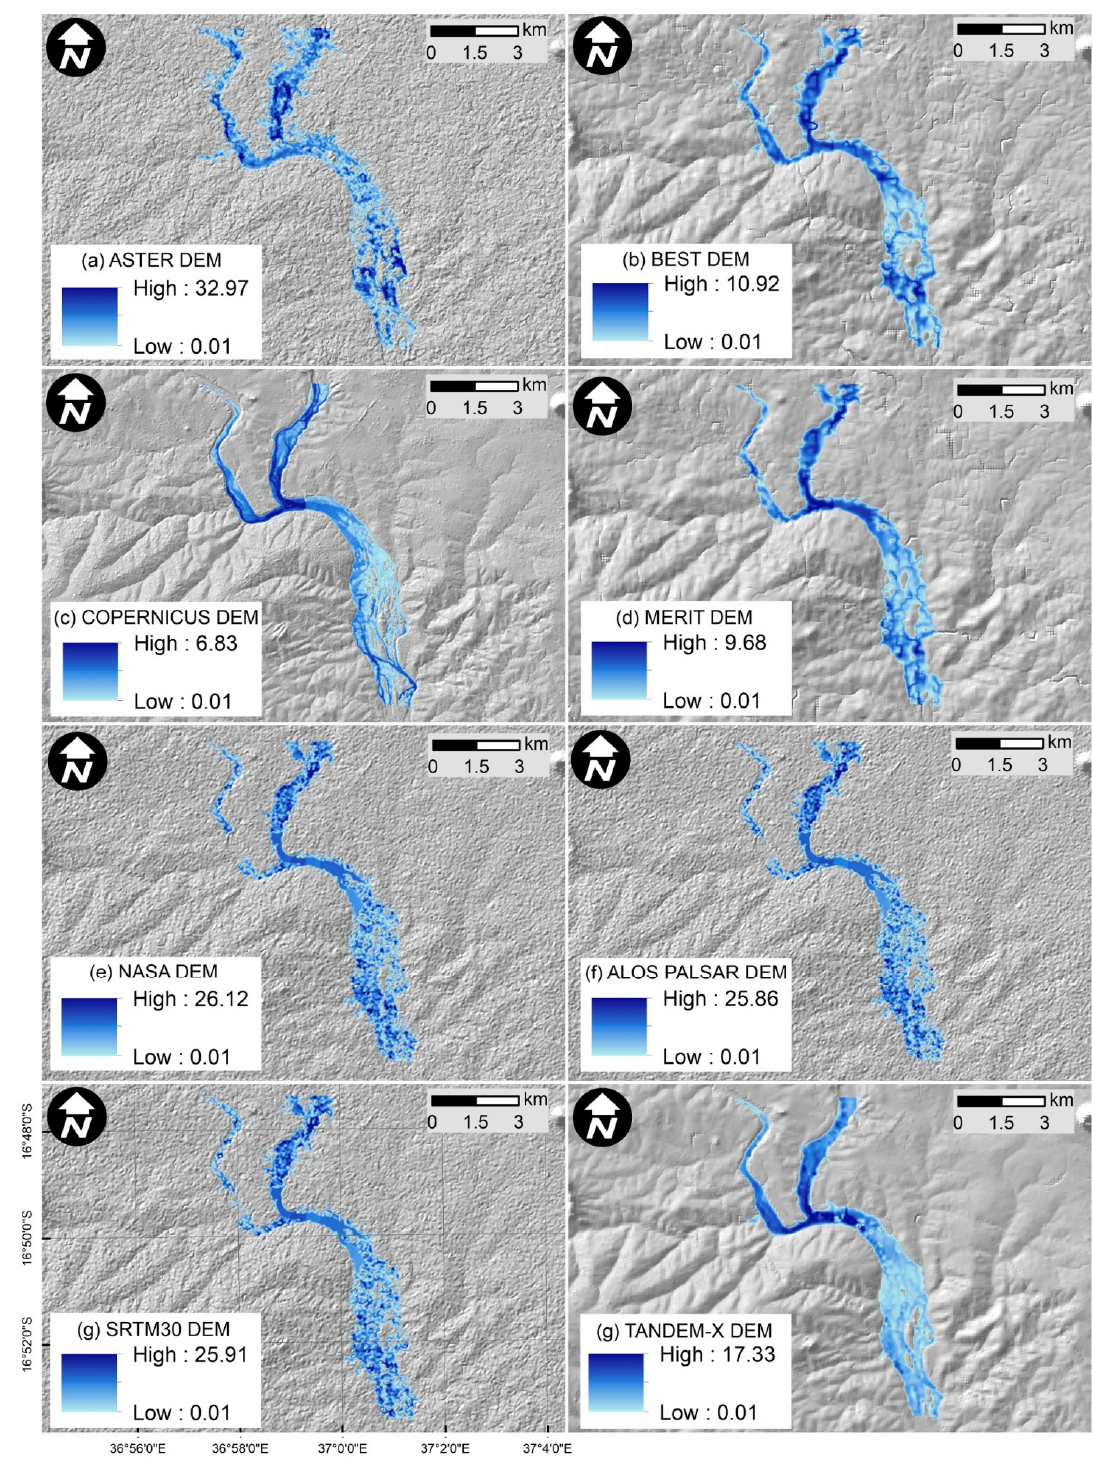
Figure 4. Flow depth results for the 10-years return period peak flow and each one of the free global DEMs used. The effect of noise errors on both the terrain surface and flow depth values ( a , e – g ).